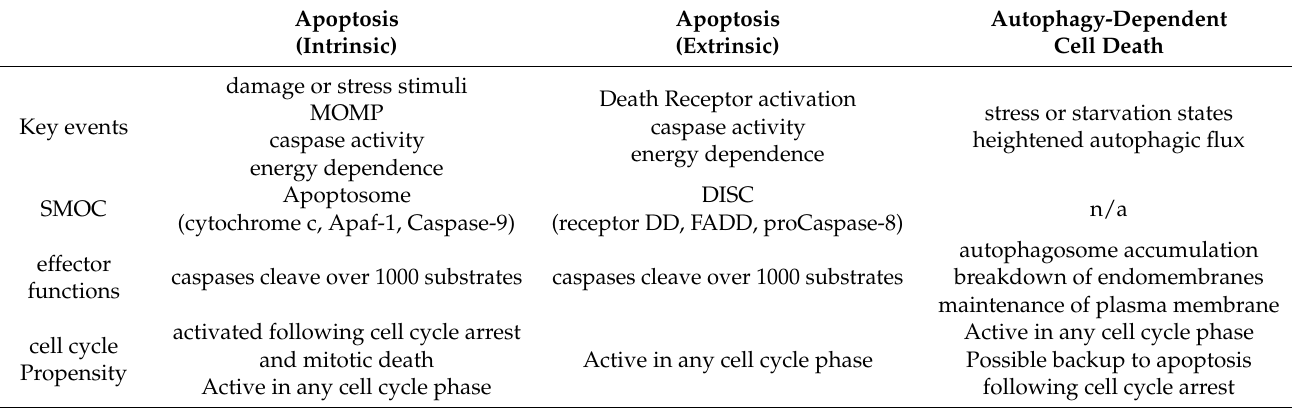
Table 2. Core components of Non-Immunogenic Death